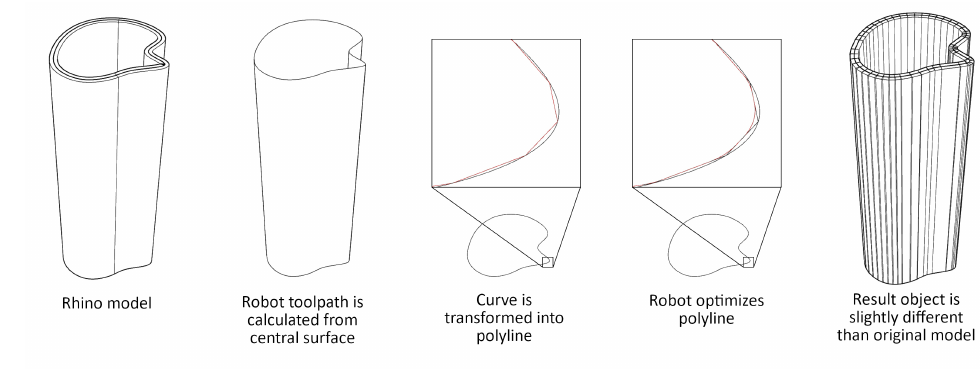
Figure 2. Robot optimization of the path.